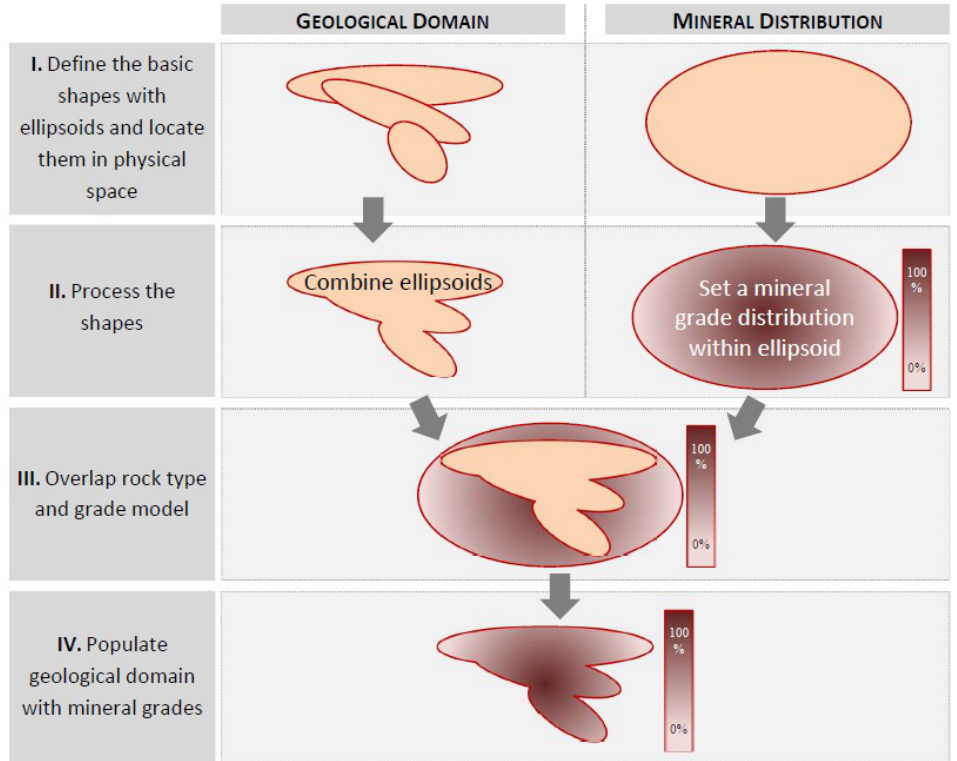
Figure 5. Applying geological domains to model rock types and property (e.g., mineral grade, elemental grade, density etc.) inside the rock type.